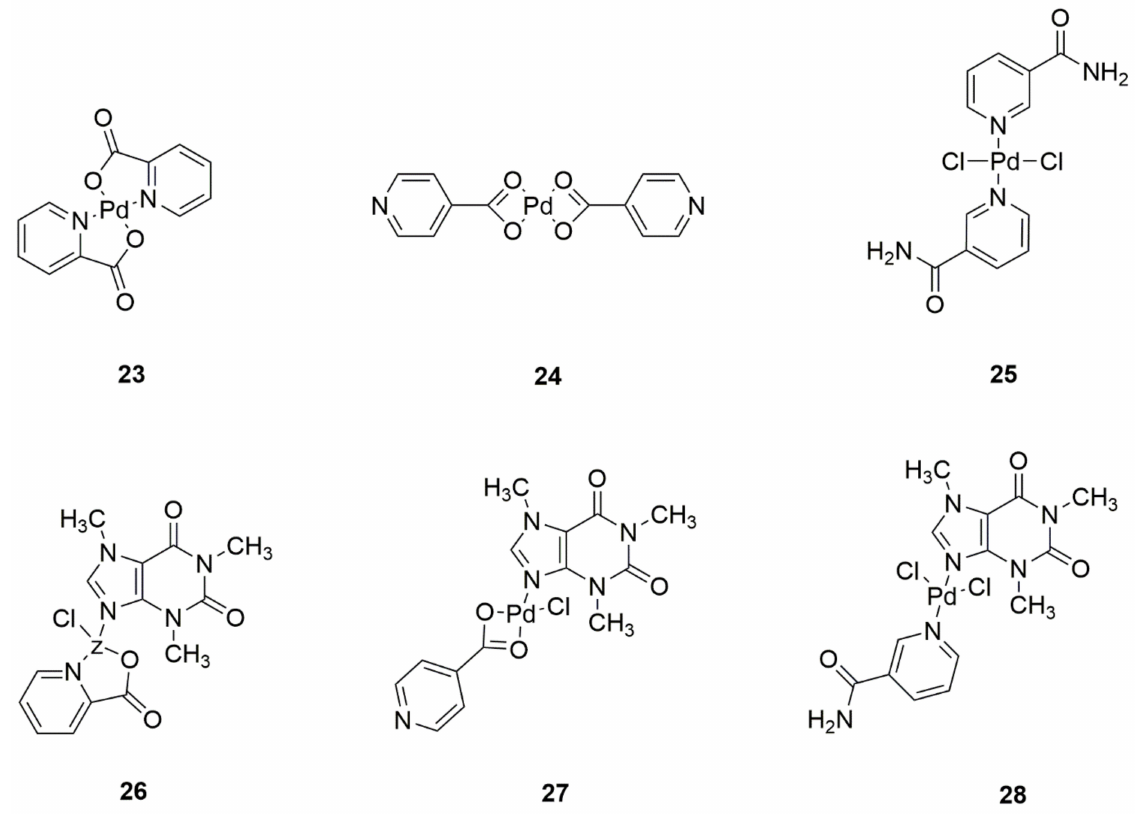
Figure 12. New palladium(II) complexes with ( 23 ) picolinic acid, ( 24 ) isonicotinic acid, ( 25 ) nicotinamide, and these complexes with an additional caffeine ligand ( 26 – 28